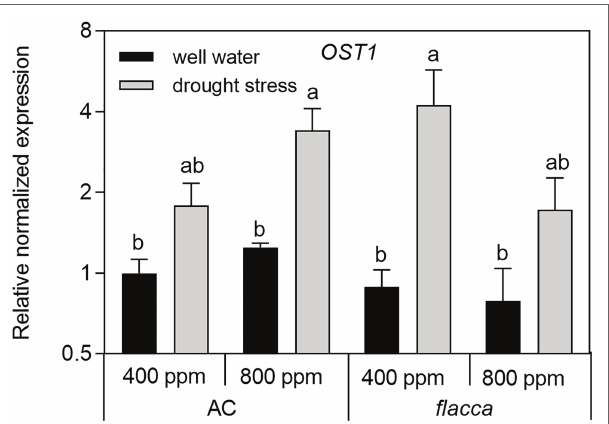
FIGURE 7 | Relative expression levels of the gene encoding the OPEN STAMATA 1 protein kinase (OST1) in leaves of AC and flacca grown under ambient (400 ppm) and elevated (800 ppm) atmospheric CO 2 concentrations after progressive soil drying. Gray columns indicate plants grown under well- watered conditions, and white columns indicate plants grown under drought stress. Different letters on the top of the columns indicate significant difference between the treatments by Tukey’s test at p < 0.05. Error bars indicate standard error of the means (SE; N =